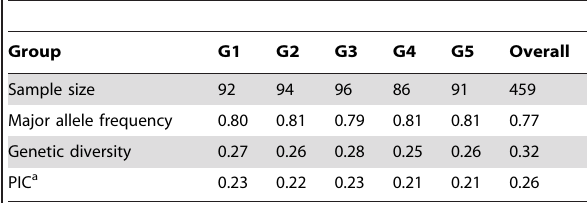
Table 1. Genetic diversity for each subpopulation grouped by structure analysis.